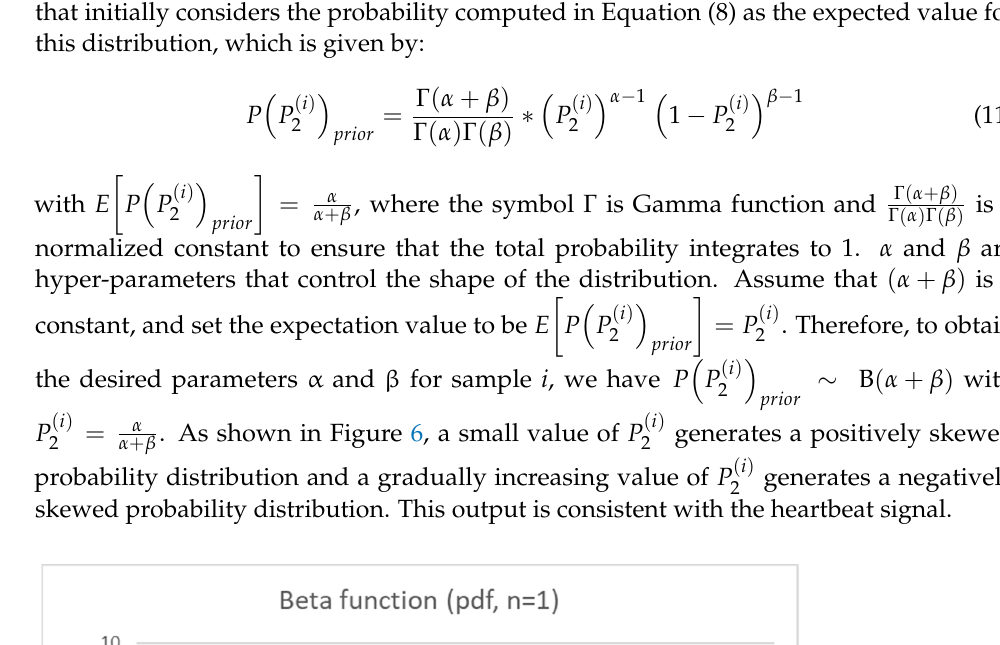
( i ) can be further set to 1 1